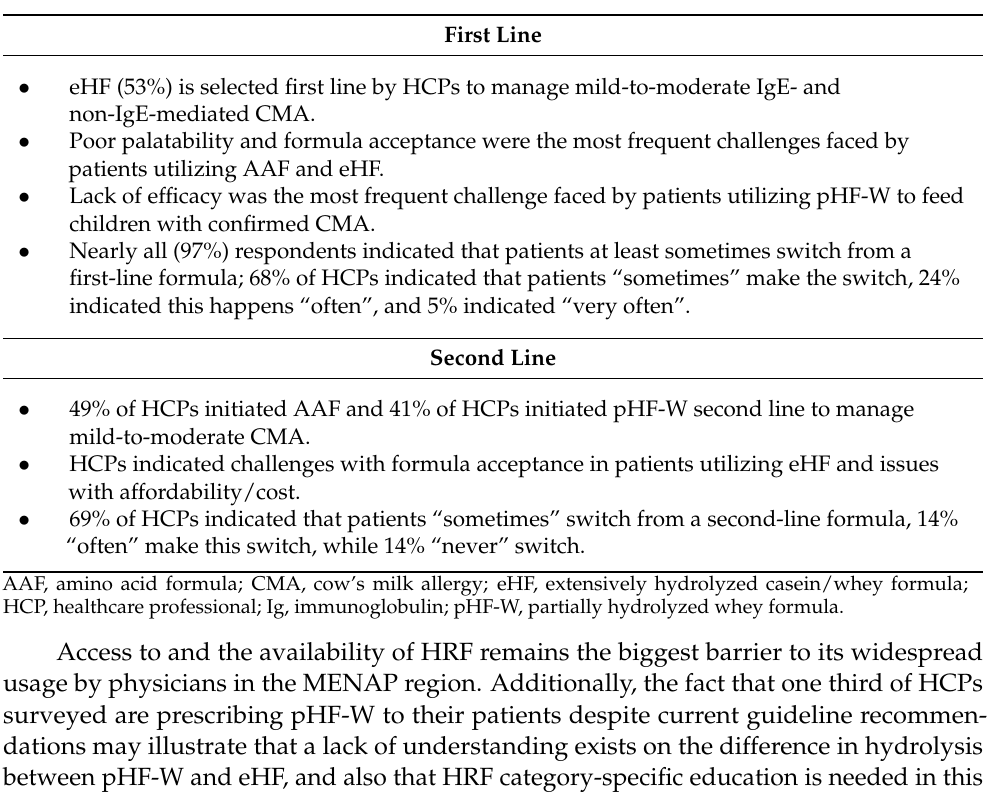
Table 1. Top-line HCP survey findings of current approaches to dietary management of CMA from the MENAP